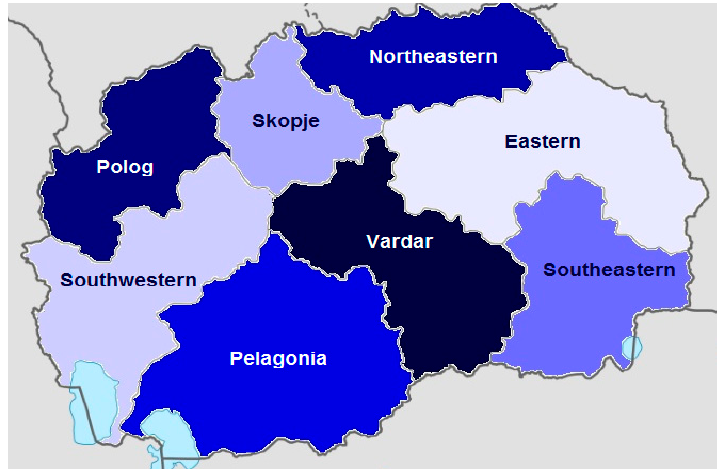
Figure 1. Regional variation in the CH incidence (brightest color corresponds with the lowest CH prevalence).